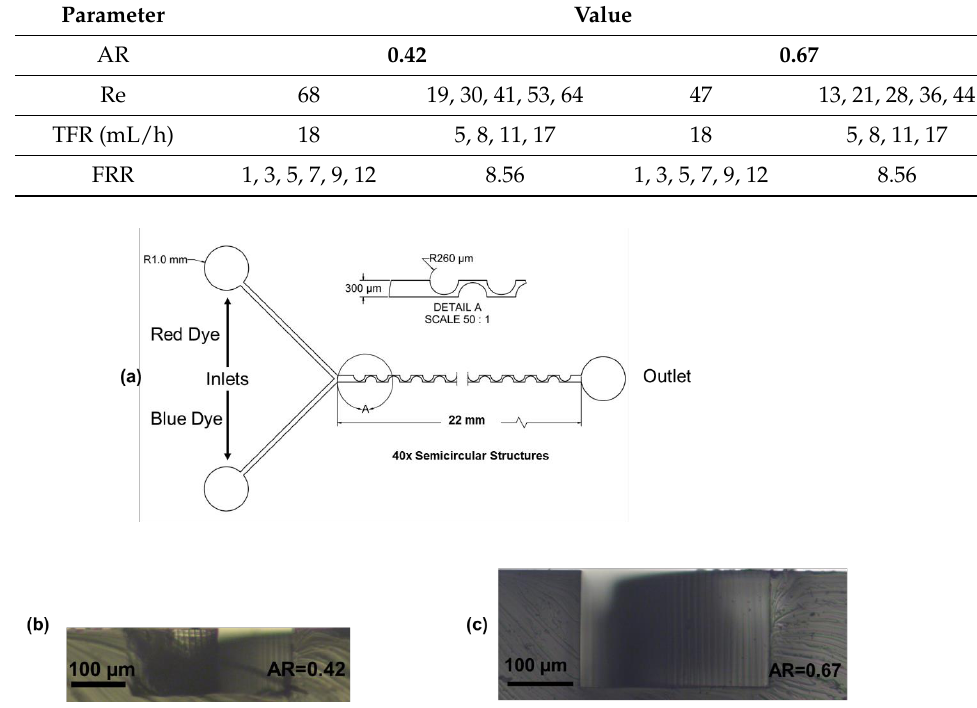
Figure 1. Periodic disturbance mixer: ( a ) schematics of the PDM; ( b ) microscopic image of the micromixer channel cross-section with an AR = 0.42, ( c ) AR =